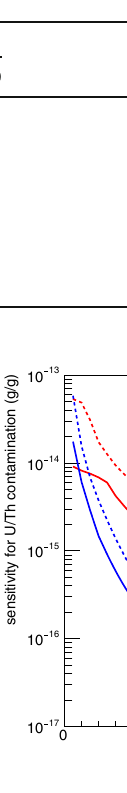
Fig. 18 Sensitivity to U/Th in the presence of an initial radon contam- ination Rn ( 0 ) . An upper limit on the constant U/Th-supported term is derived from a time fit to the observed Bi–Po-rate, taking the known decay profiles of 222 Rn / 220 Rn into